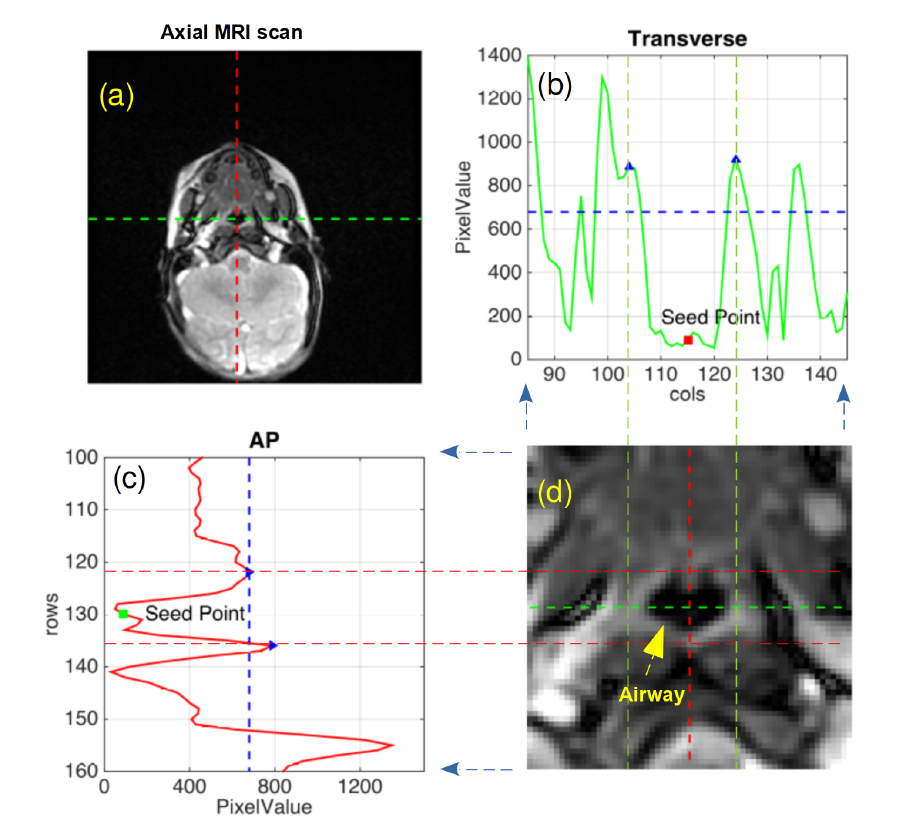
Figure 1. ( a ) A sample MR image at the nasopharyngeal plane of the upper airway, randomly selected from the 72 CINE MR images of continuous breathing in a study participant; Changes in pixel intensity values in the MR image along the ( b ) transverse (TX) and ( c ) anterior-posterior (AP) axes; ( d ) Cropped view of MR image shown in ( a ); The length and breadth of cropped image in ( d ) are aligned with rows and column axes. The blue triangles in ( b ) and ( c ) which are at the local peaks along TX and AP axes gives the extent of airway (red and green dashed lines) in ( d